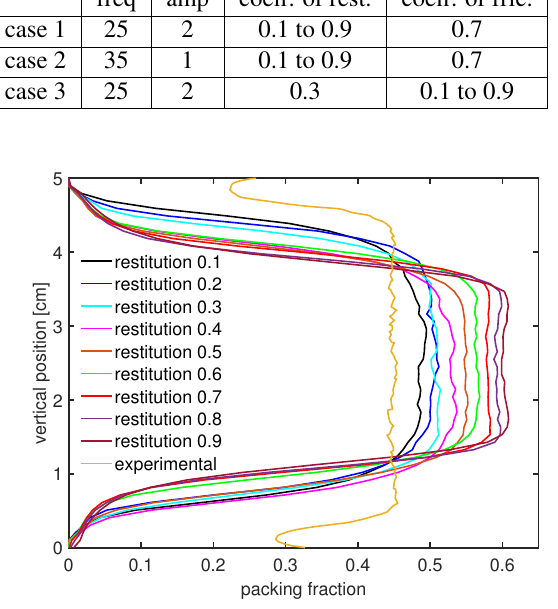
Figure 2. Numerical simulation using a frequency of 25 Hz and amplitude of 2 mm. The coe ffi cient of restitution was varied from 0.1 to 0.9. The corresponding experimental result is also shown in the